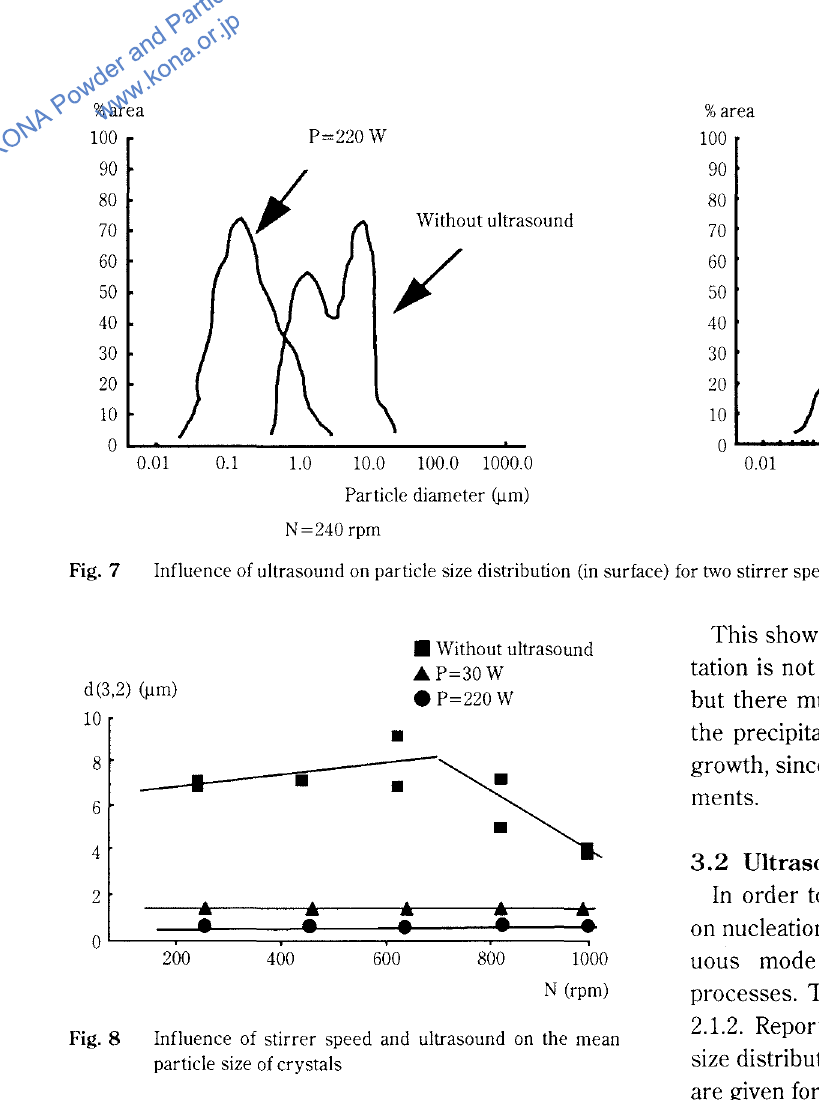
Influence of stirrer speed and ultrasound on the mean particle size of crystals